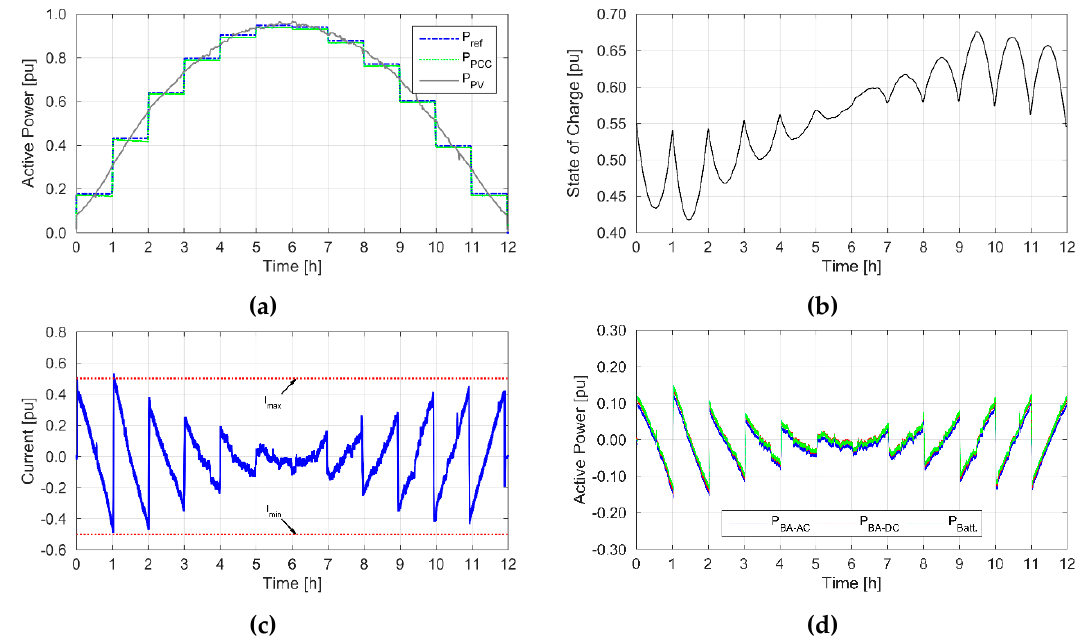
Figure 7. Selected values obtained during simulation tests: ( a ) power curves, ( b ) the state of charge (SOC) curve of the battery energy storage, ( c ) the current measured at the battery output, ( d ) power curves. Where P ref is the reference power, the average power over an hour that results from the declared amount of electricity to be supplied at the PCC; P PCC is the power supplied at the PCC; P PV is power output of the PV installation; I max, I min are maximal and minimal accepted current levels, P BA-DC is power level at the DC side of the battery energy storage system; P Batt. is power output at battery terminals; P BA-AC is power level at the AC side of the battery energy storage system.